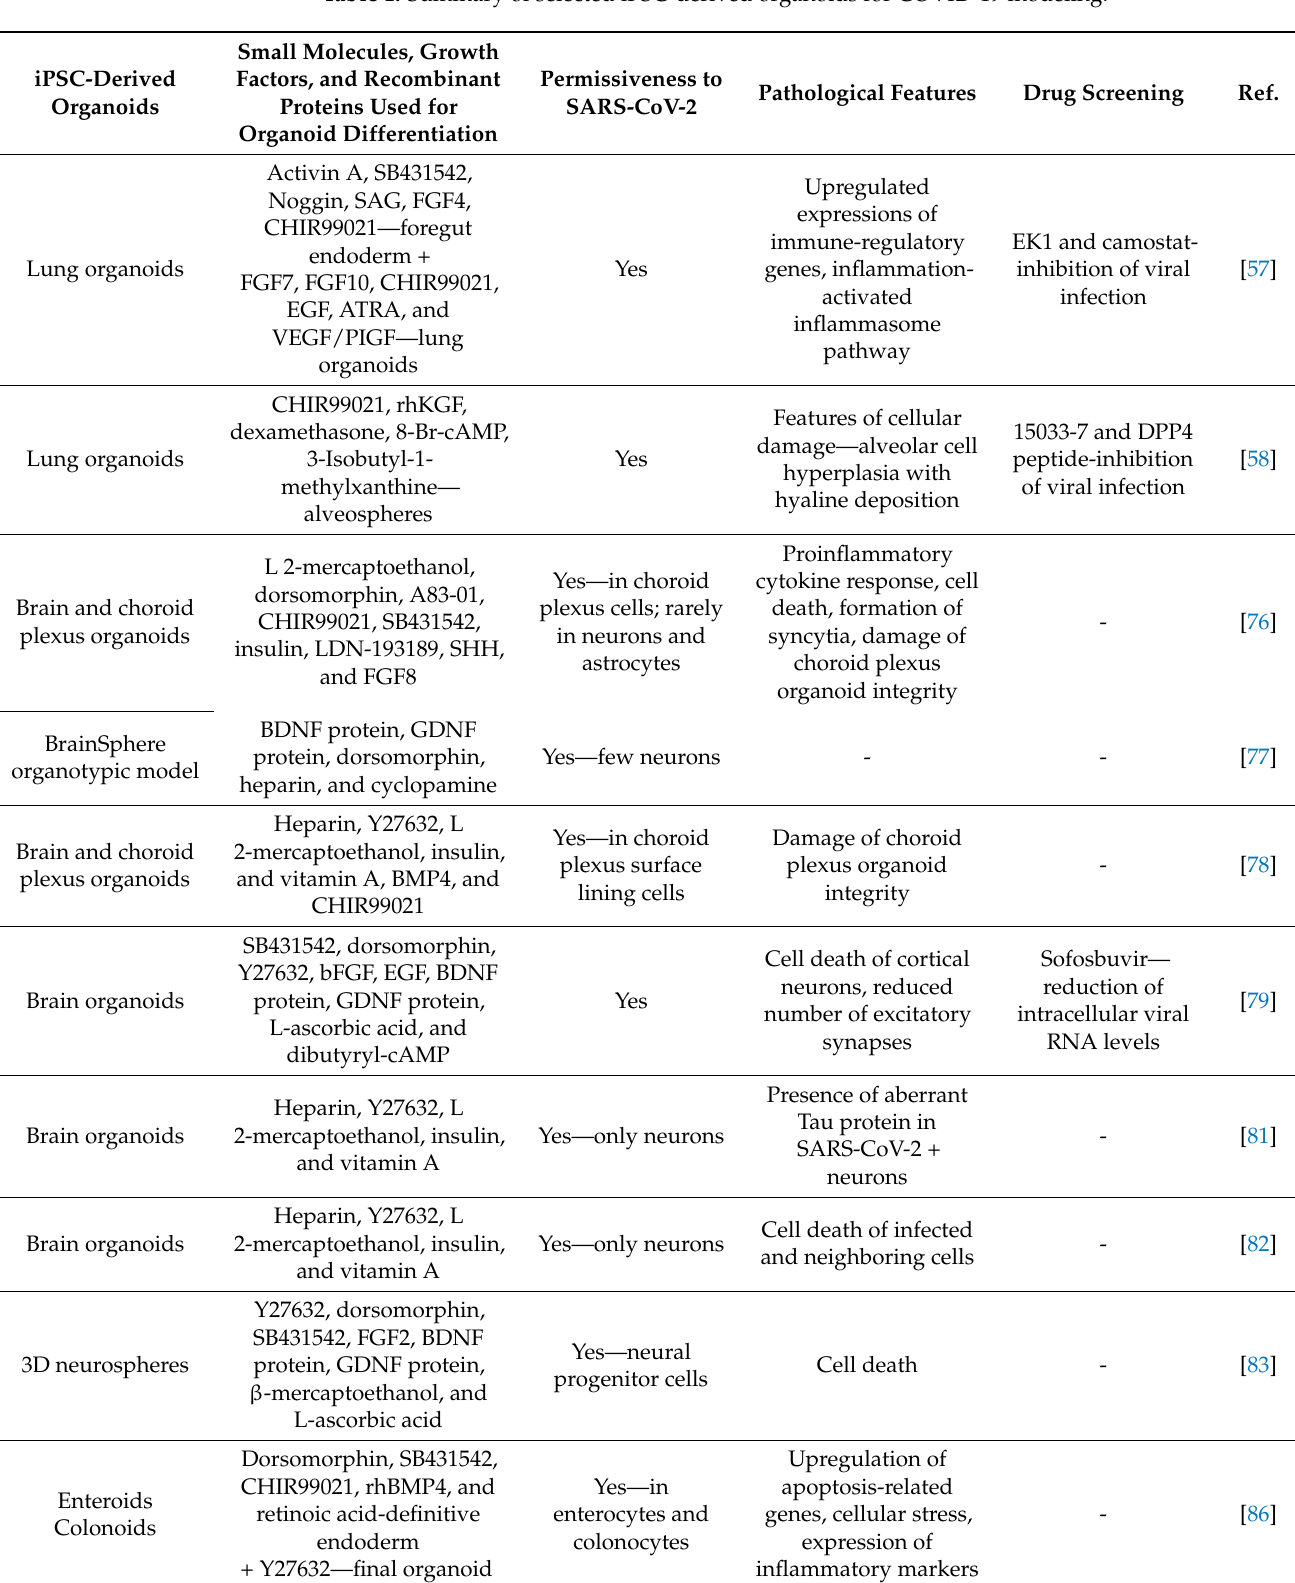
Table 1. Summary of selected iPSC-derived organoids for COVID-19 modeling.